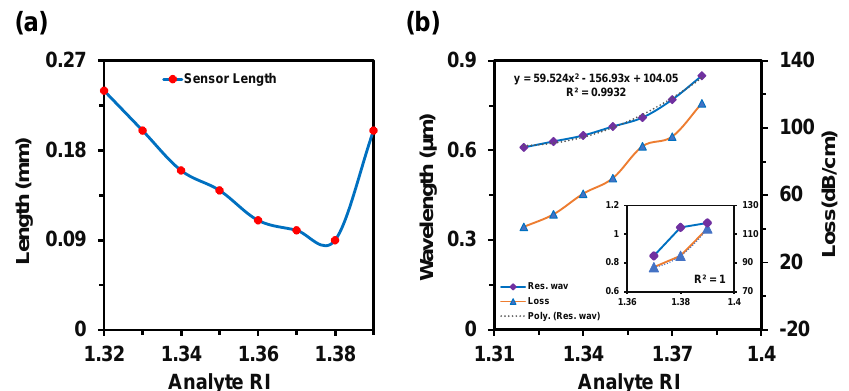
Figure 8. ( a ) Sensor length and ( b ) resonance wavelength shift and loss curve fitting of the proposed sensor as a function of analyte RI from 1.32 to 1.39.